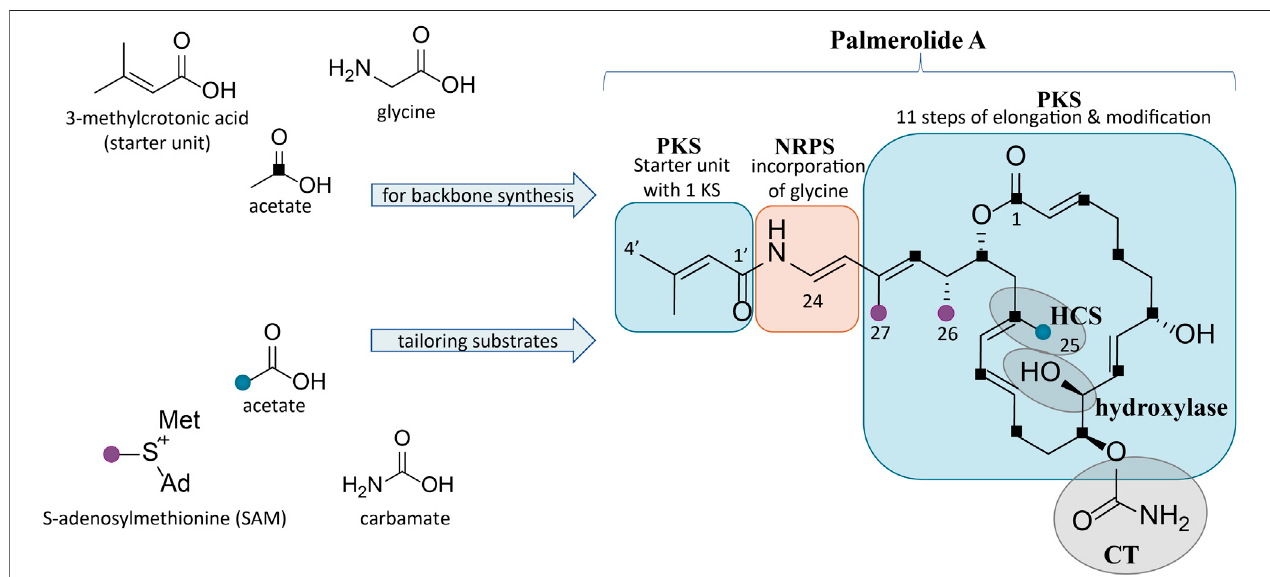
FIGURE1| StructureofpalmerolideAwithnotationsfortheproposedretrobiosynthesis.Backbonesynthesisisaresultofincorporationofthestarterunit,aglycine residue, and acetate subunits (C1 indicated by black squares). Structural features from trans -acting tailoring enzymes (indicated by grey ovals) utilize additional substrates: methyl transfers from SAM (purple dots), installation of C-25 methyl from acetate (blue dot) via an HCS cassette, and carbamoyl transfer to the secondary alcohol on C-11. The α -hydroxy group on C-10 is predicted to arise from incorporation of hydroxymalonic acid or a trans -acting hydroxylase.